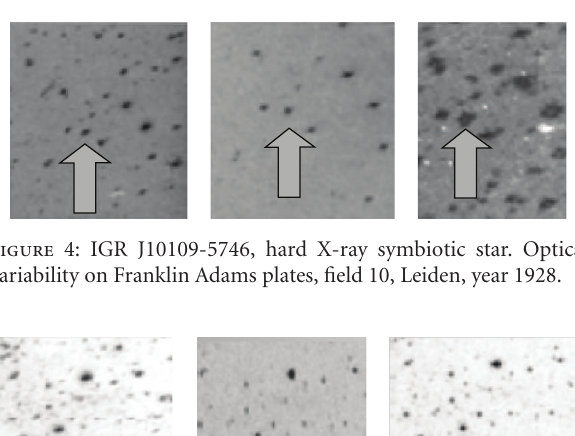
Figure 2: The coverage of INTEGRAL IBIS for revolutions 1–430.